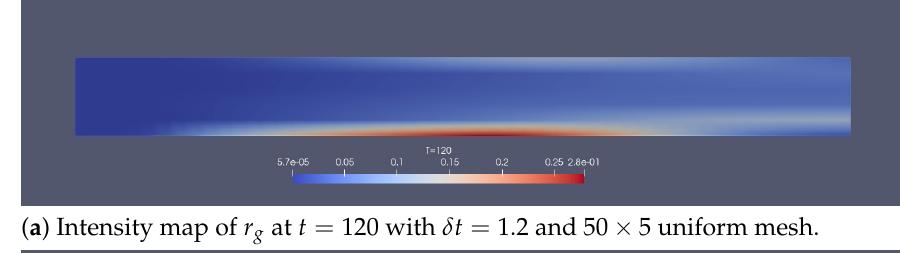
( a ) Intensity map of r g at t = 120 with δ t = 1.2 and 50 × 5 uniform mesh.